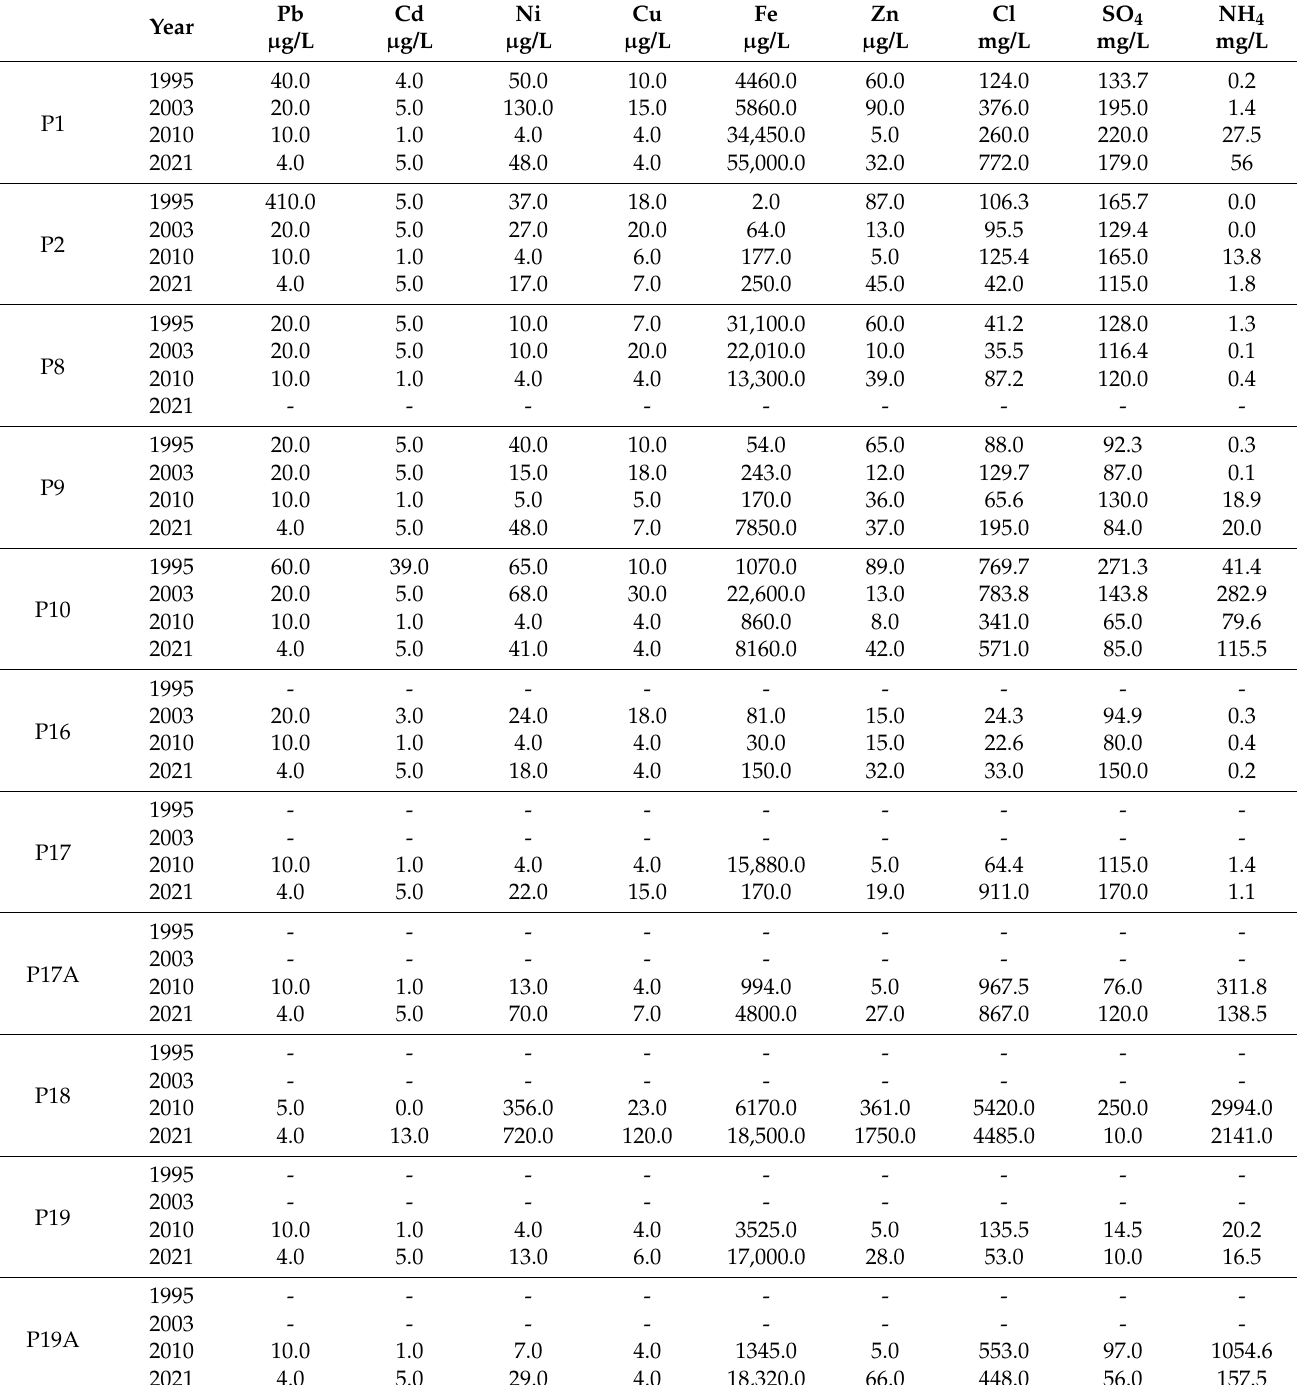
Table 4. Chemical analysis results in 1995, 2003, 2010, and